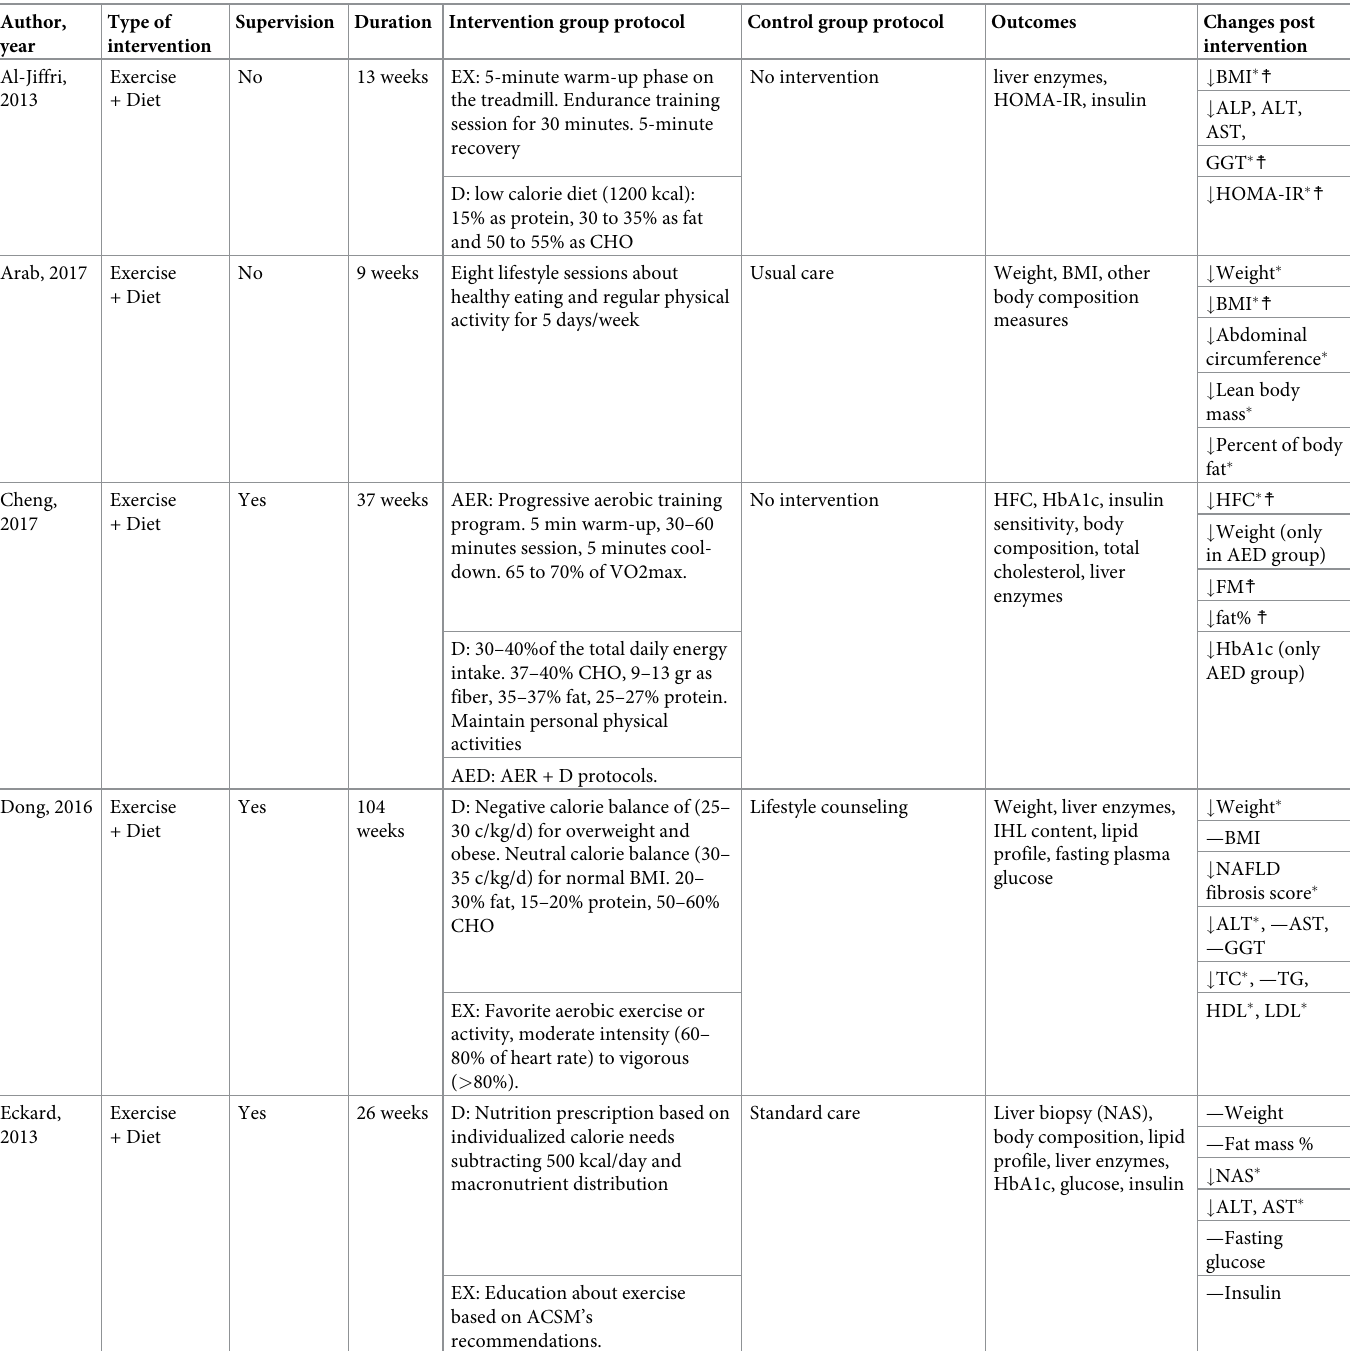
Table 4. Trials evaluating combination of diet and exercise in NAFLD